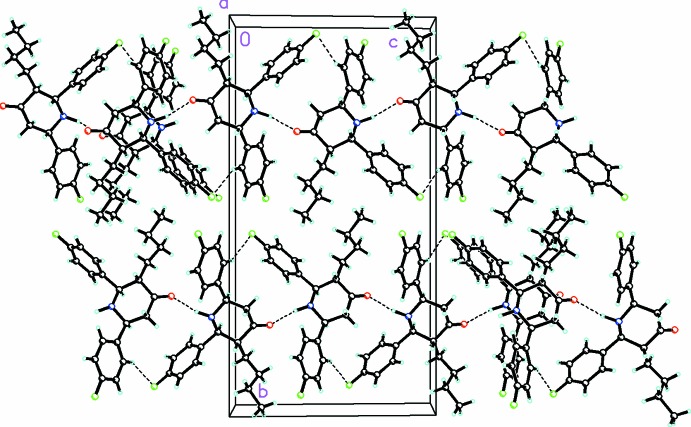
Crystal packing for C21H23F2NO viewed along the a-axis direction. Dashed lines indicate N—H⋯O hydrogen bonds and weak C—H⋯F inter­actions forming (14) loops and infinite C(6) chains (via the N—H⋯O bond) along the c-axis direction.